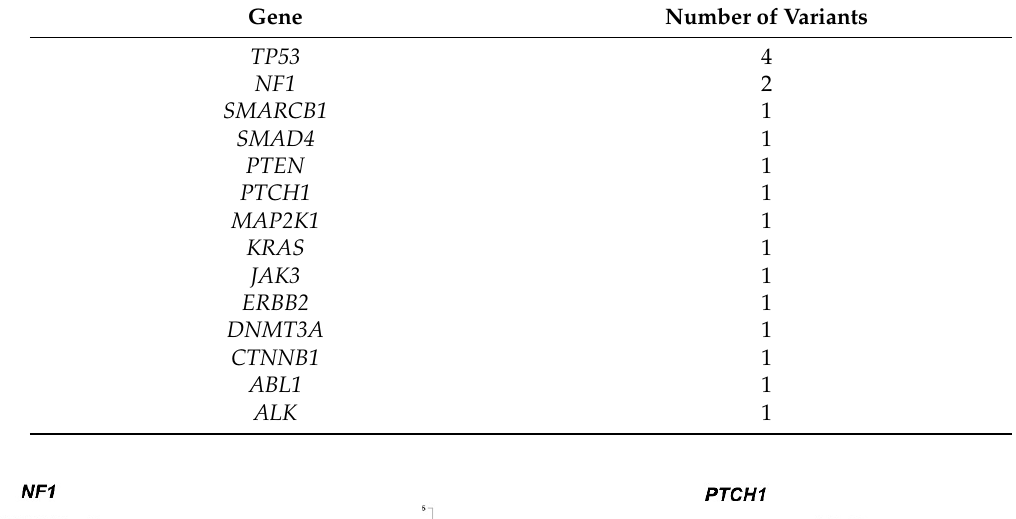
Table 5. Variants detected in oncogenes/tumor-suppressor genes in all sequenced CTCs within a subject that were shared by ≥ 2 NSCLC patients.